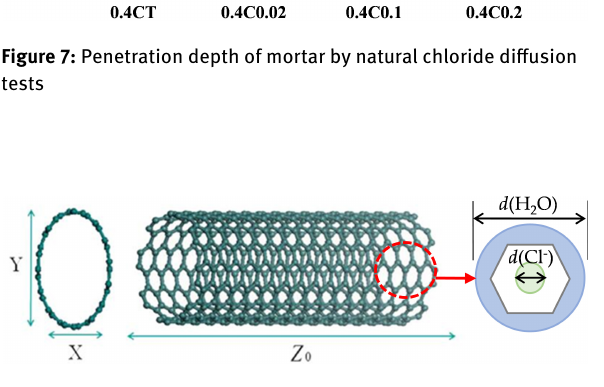
Figure 8: Microstructure diagram of carbon